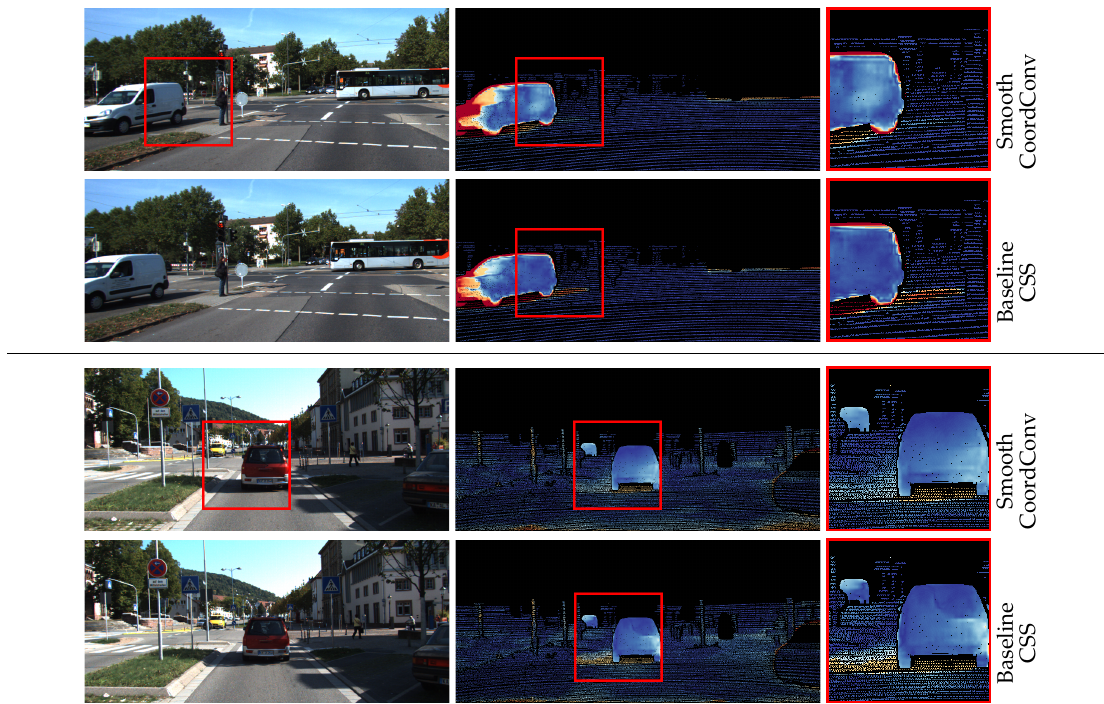
Figure 18. Typical examples of improved shadow handling with our approach. Shadows that appear to move with their casting objects are better mapped to the